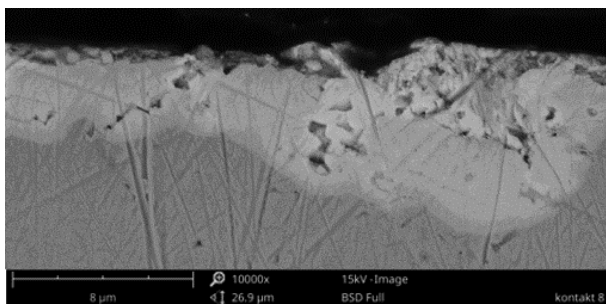
Fig. 9. Scanning microscope image of sample number 5 – a continuous layer, with uneven coating thickness, and numerous impurities